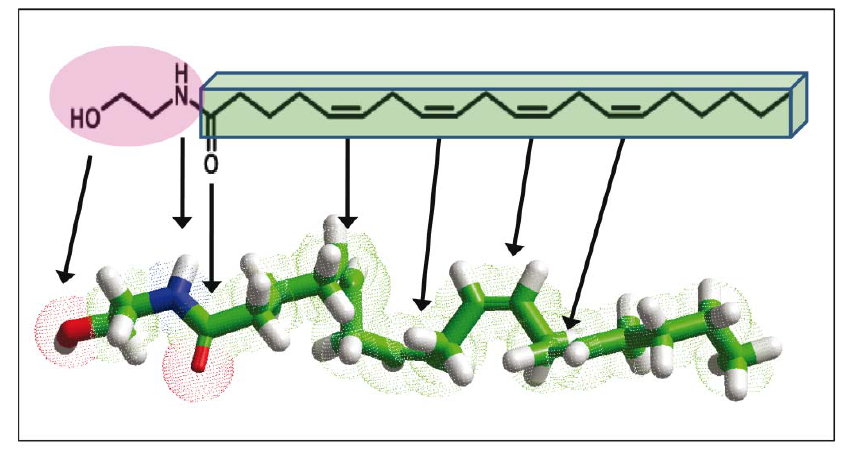
Figure 1. Chemical structure of anandamide (AEA). Anandamide is derived from arachidonic acid. The apolar moiety (in the box) contains 4 double bonds. The polar part (in mauve) is an ethylamine group. In the molecular model carbon atoms are in green, nitrogen in blue, oxygen in red, and hydrogen in white.